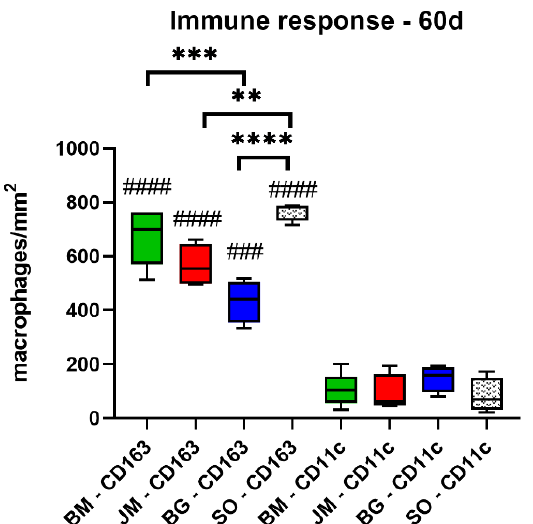
Figure 9. Exemplary histological images of the distribution of anti-inflammatory CD163-positive macrophages ( A – D ) and pro-inflammatory CD11c-positive macrophages ( E – H ) (red staining) within the implant beds of the three membranes within the subcutaneous connective tissue (CT) at day 60 post implantationem. ( A ) BM = Bovine membrane, ( B ) JM = Jason ® membrane, ( C ) BG = Bio-Gide ® membrane, ( D ) Sham operation group without biomaterial insertion (CD163-immunostainings ( A – D ) and CD11c-immunostainings ( E – H ), 200× magnifications, scalebars = 200 µm).